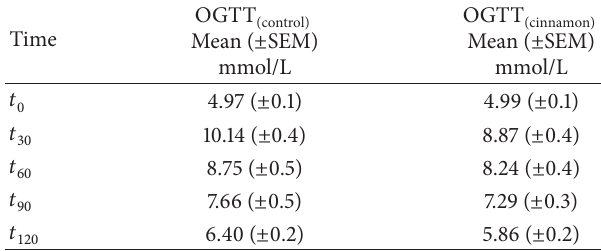
Table 3: Mean blood glucose levels (mmol/L) obtained after oral ) and after oral glucose tolerance glucose tolerance test (OGTT (control) ) at different moments: test with cinnamon tea (OGTT (cinnamon) before OGTT ( 𝑡 0 ) and after 30 ( 𝑡 30 ), 60 ( 𝑡 60 ), 90 ( 𝑡 90 ), and 120 ( 𝑡 120 ) minutes. Data are mean ± SEM; 𝑛 = 15 , each